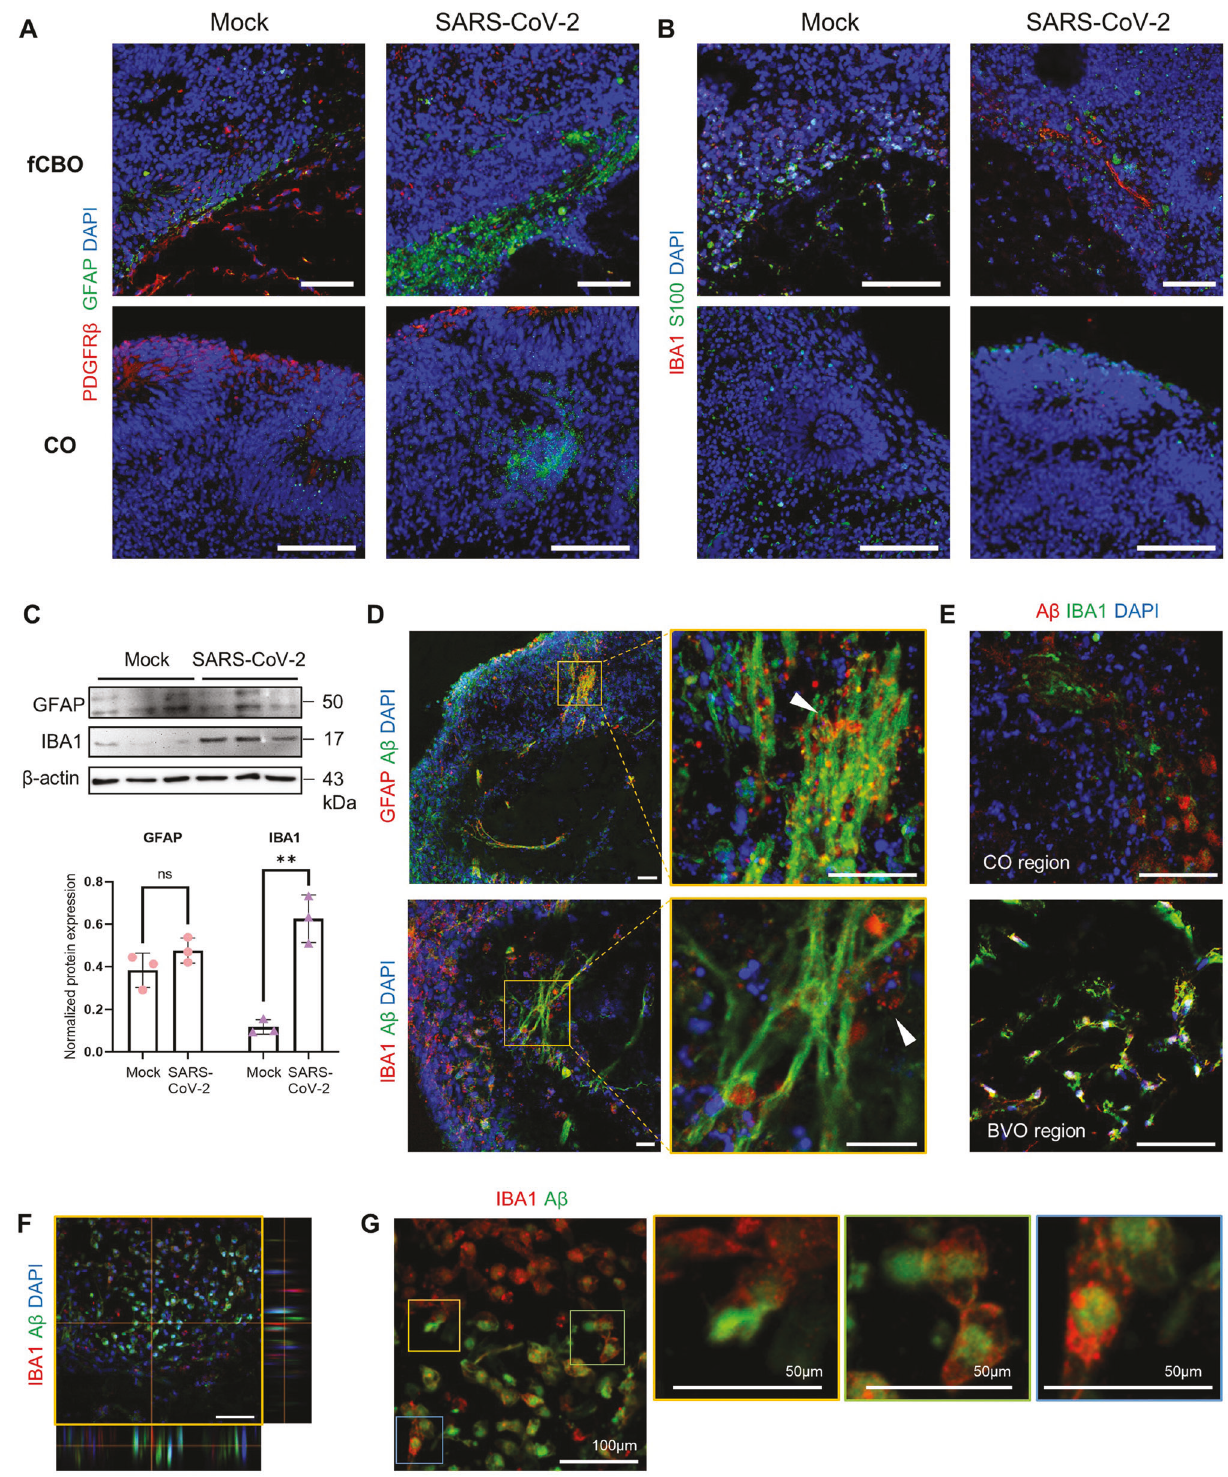
Fig. 6 Recruitment of microglia/macrophages and astrocytes after SARS-CoV-2 infection in fused cortical-blood vessel organoids. A Immunostaining of SARS-CoV-2 or mock infected fCBOs and COs for GFAP and PDGFR β . Scale bar = 100 μ m. B Immunostaining of SARS-CoV-2 or mock infected fCBOs and COs for IBA1 and S100. Scale bar = 100 μ m. C Western blot for GFAP, IBA1 and the loading control β -actin of SARS-CoV-2 or mock infected fCBOs and relative protein levels ( n = 3). D Immunostaining of SARS-CoV-2 infected fCBOs for A β and GFAP or IBA1. Accumulated astrocytes (upper arrow) or microglia/macrophages (lower arrow) around A β plaques. Scale bar = 100 μ m. E Immunostaining of SARS-CoV-2 infected fCBOs for A β and IBA1. Rami fi ed microglia accumulated in A β + cells in cortical organoid region and blood vessel organoid region. Scale bars = 50 μ m. F Representative Z-stack image of immunostaining of SARS-CoV-2 infected fCBOs for IBA1 and A β . IBA1 + microglia/macrophages accumulated around A β + cells. G Zoom-in image of glial phagocytosis of A β + cells (yellow, green and blue boxes). Values represent mean with individual data points plotted. Error bars are SEM of the mean. * p < 0.05, ** p < 0.01, *** p < 0.001 by unpaired two-sided t -test. Cell Death Discovery (2023)